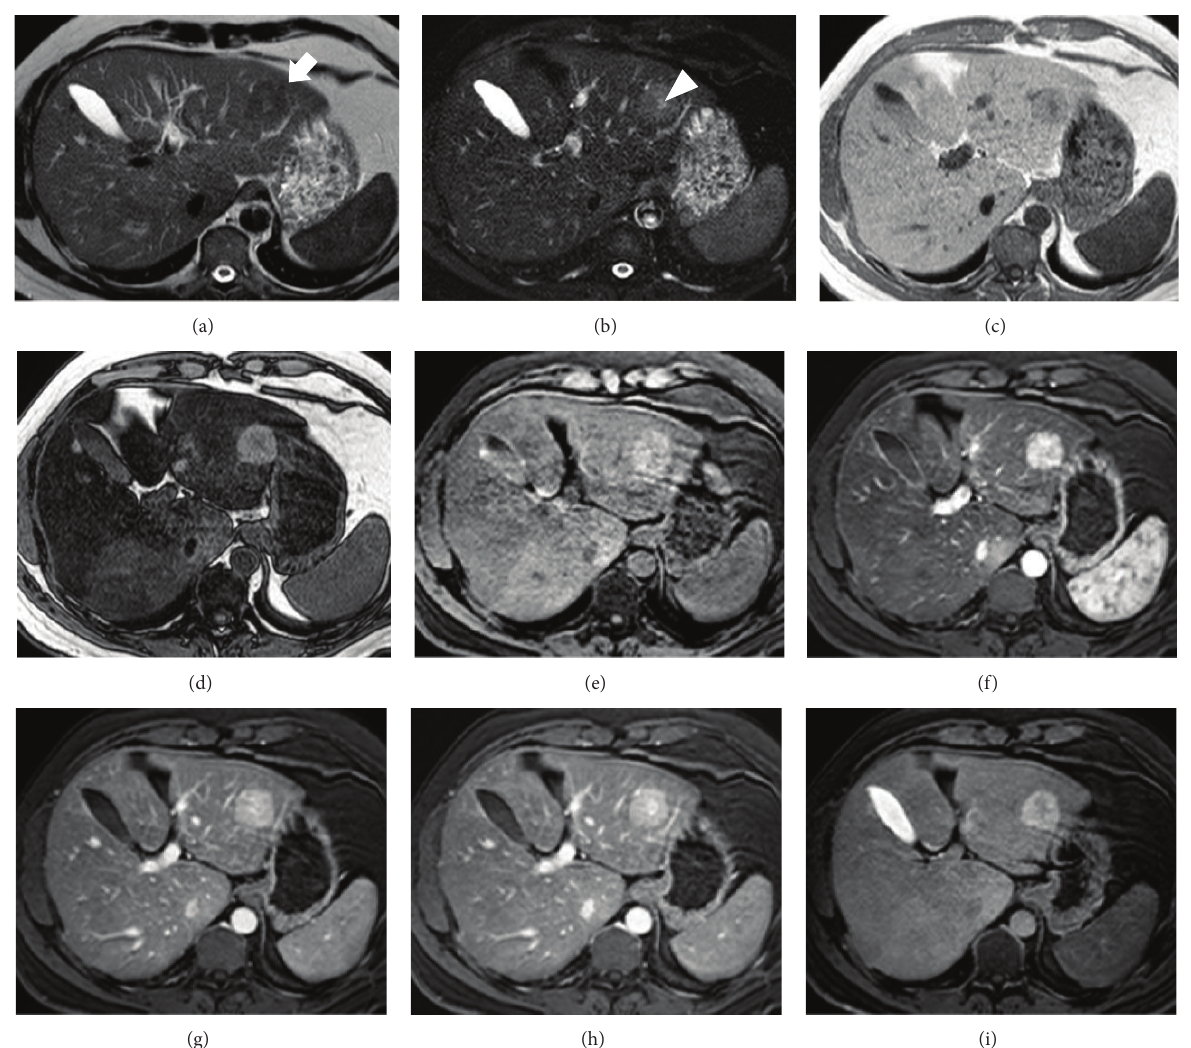
Figure 7: Focal nodular hyperplasia in fatty liver. (a-b) Axial T2w images without (a) and with (b) fat suppression. In S II slightly hypointense (a) and hyperintense (b) lesions (arrow) with hyperintense central scar (arrowhead). (c-d) Due to significant steatosis of hepatic parenchyma the lesion is hypo- and hyperintense in T1w in- and out-phased images. (e–h) In dynamic evaluation after Gd-BOPTA administration the nodule appears significantly hypervascular in arterial phase (f) and tends to be hyperintense in portal and equilibrium phases. Typically central scar becomes hyperintense in equilibrium phase. (i) Hepatobiliary phase image after 1 hour. The lesion is hyperintense except central scar which is hypointense with stellate